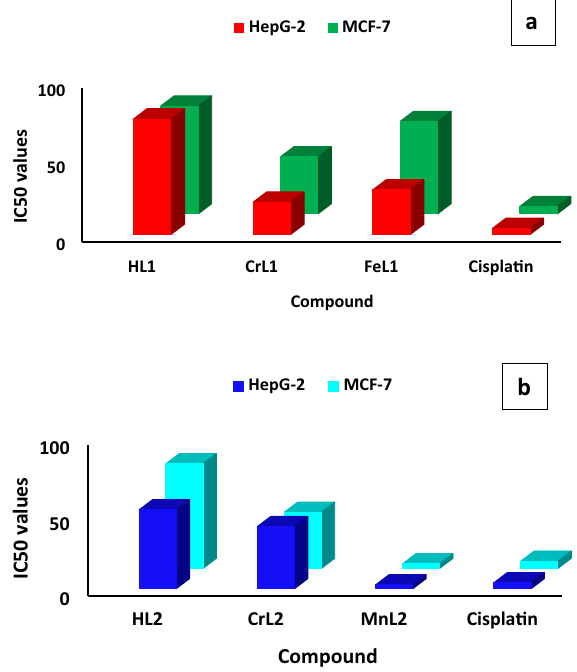
Figure 11. Cytotoxicity of HL1 and its CrL1 and FeL1 complexes ( a ) and HL2 and its CrL2 and MnL2 complexes ( b ) against MCF-7 and Hep-G2 compared to